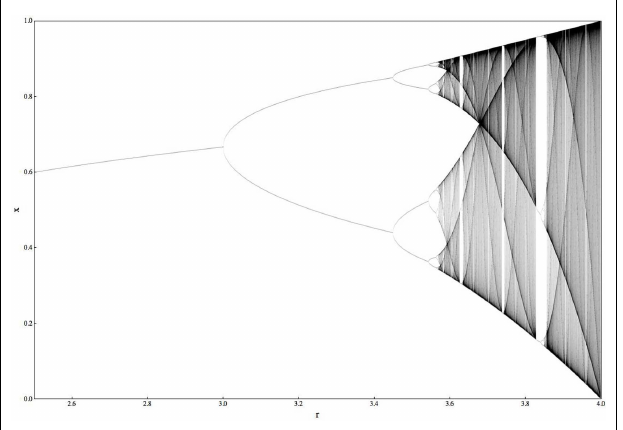
FIGURE 7 |The march to chaos (Camazine et al., 2001).